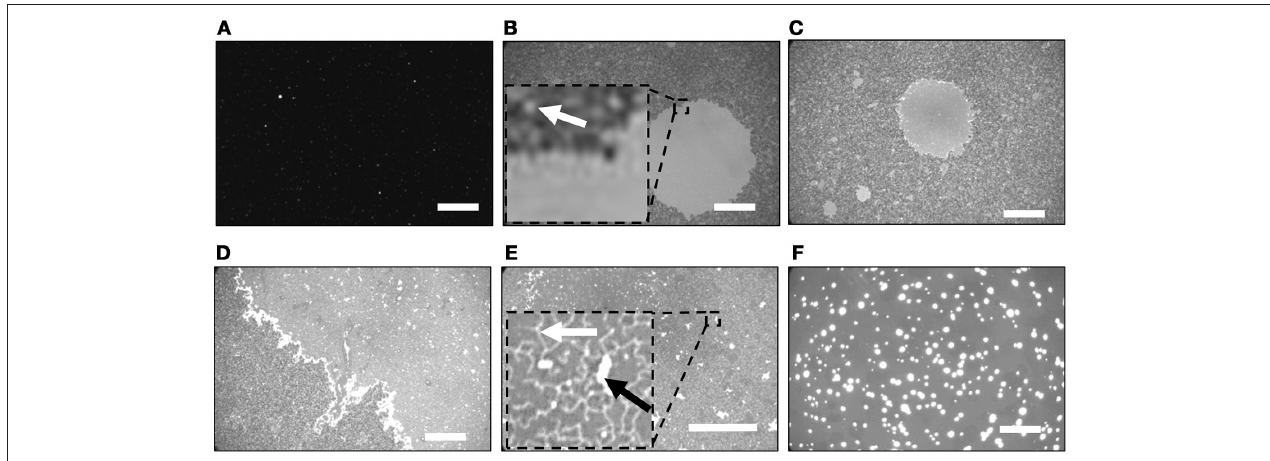
FIGURE 1 | Fluorescence images of SiO 2 /Si substrates after incubated in the PLE-vesicle suspensions with [Ca 2 + ] = (A) 0, (B) 2.0, (C,D) 2.5, (E) 3.0, and (F) 5.0mM. (B,E) Insert: magnified image of the dotted square region. Representative SLB patch is indicated with a white arrow in (B) . The string-like structure and the region two times brighter than the surrounding are indicated with a white arrow and a black arrow in (E) , respectively. Scale bars are 50 µ m.